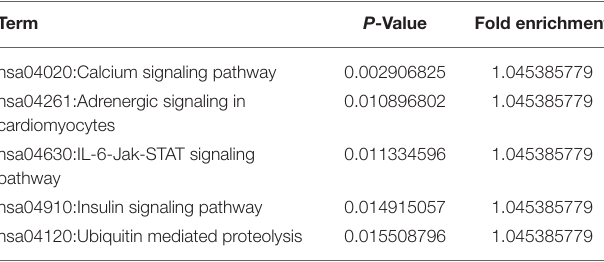
TABLE 3 | DAVID pathway enrichment analysis.